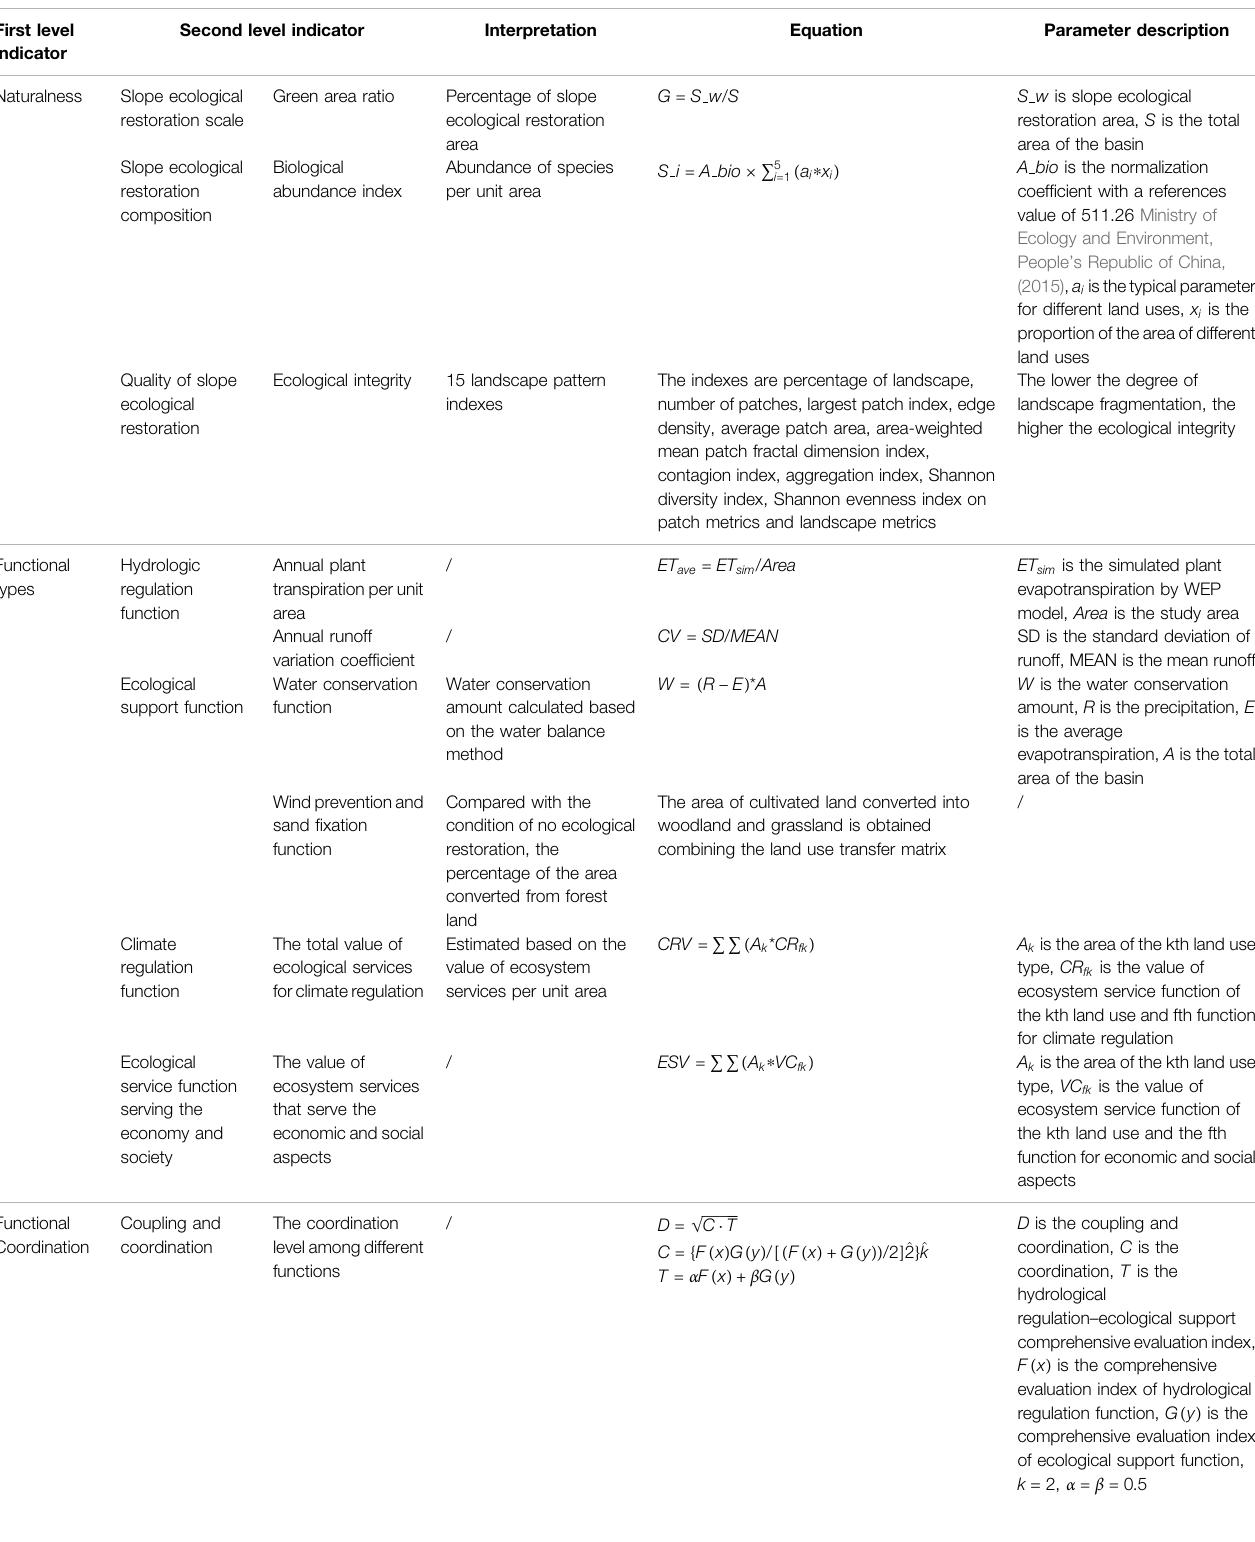
TABLE 2 | Index system for evaluation of slope ecological